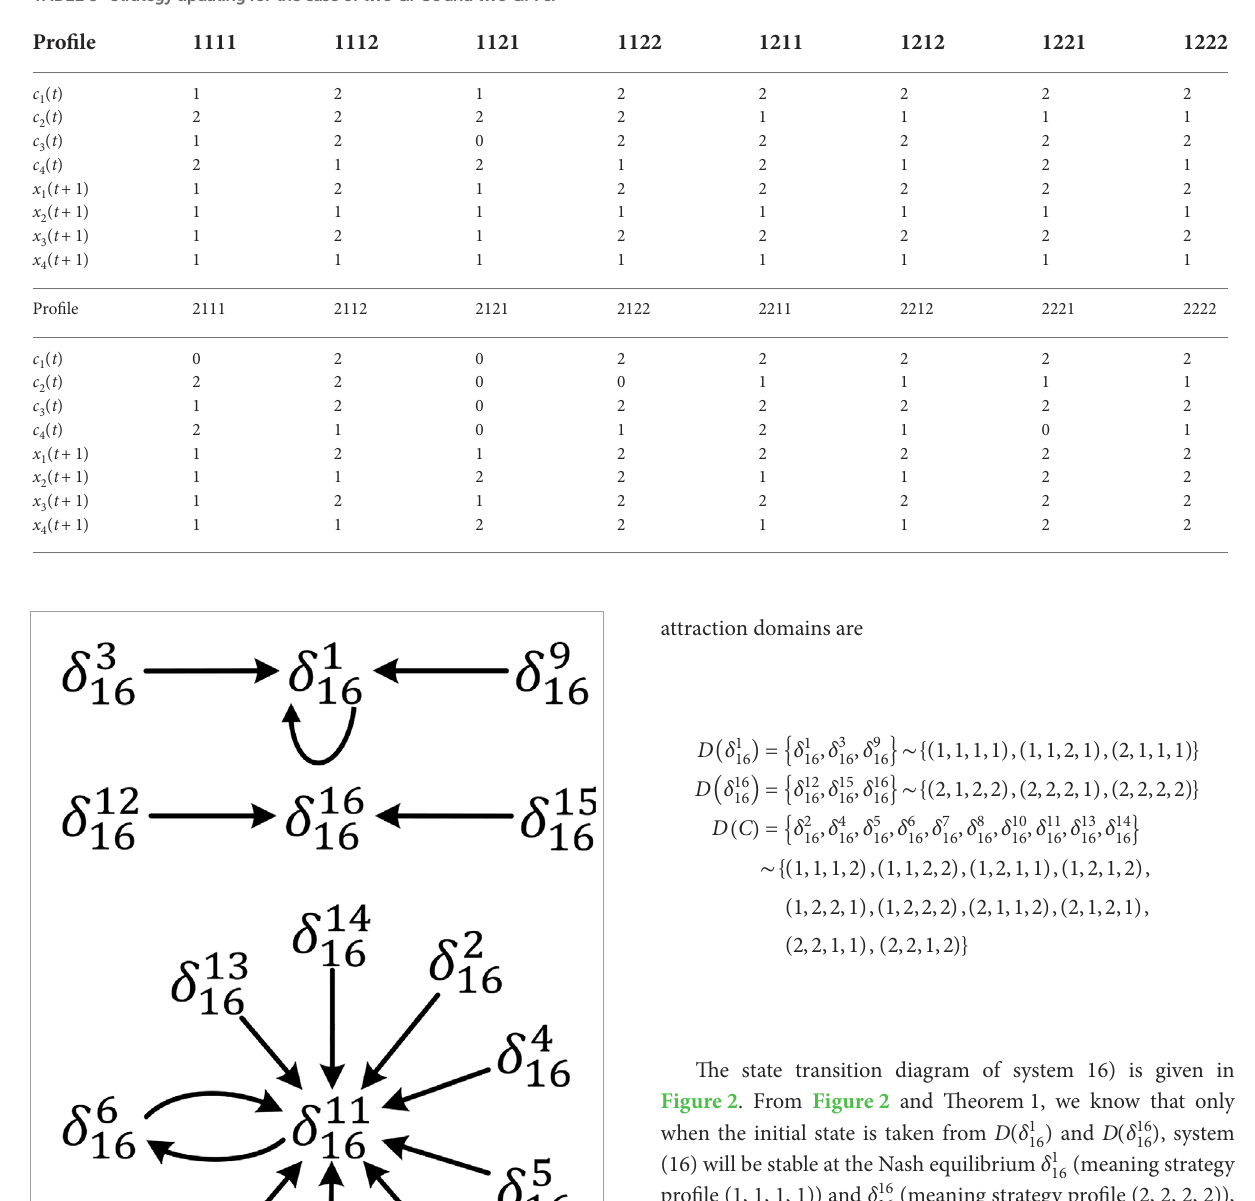
) and D ( δ 16 ) , system 16 16 (meaning strategy 16 (meaning strategy profile (2, 2, 2, 2)), 16